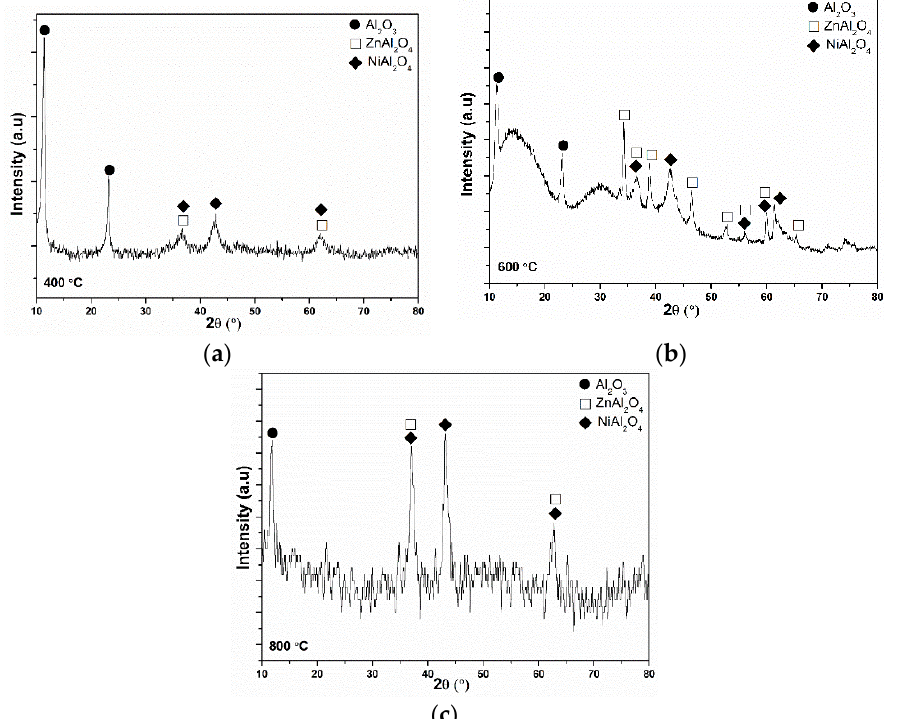
Figure 4. XRD patterns of mixed oxides NiO/ZnO/Al 2 O 3 obtained with different reaction tempera- ture: ( a ) 400 °C; ( b ) 600 °C; ( c ) 800 °C.